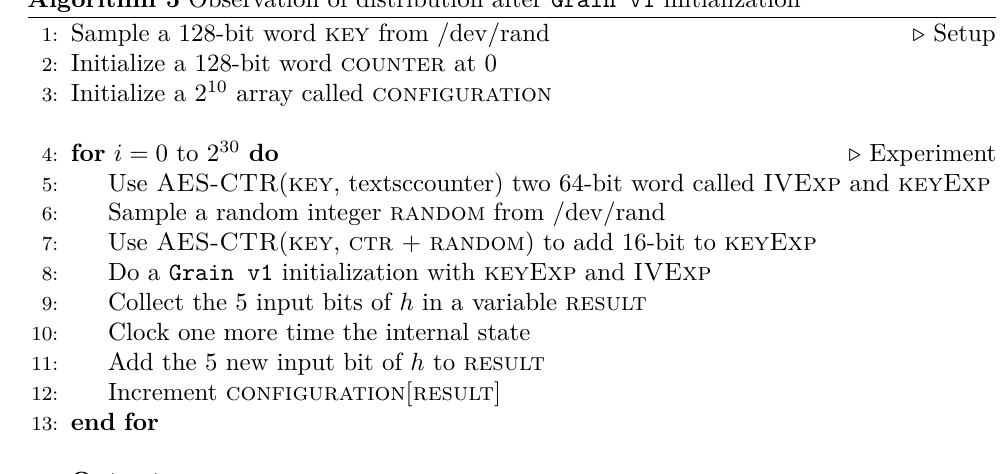
Algorithm 5 Observation of distribution after Grain v1 initialization